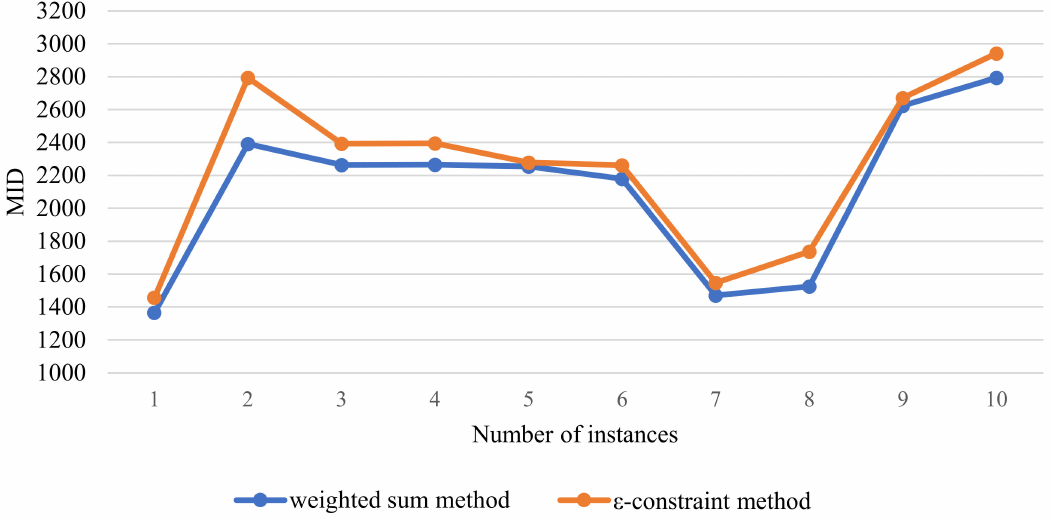
Figure 6. Comparison of ε ‑constraint and weighted sum